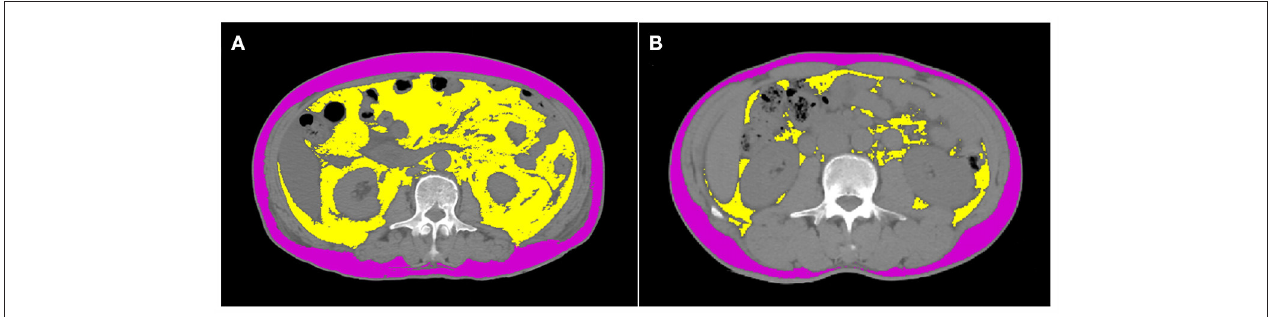
FIGURE 1 | Computed tomograph scan shows the body composition of normal BMI individuals with and without visceral obesity. (A) represents a normal BMI with visceral obesity, with a BMI of 23.2 kg/m 2 and visceral adipose tissue of 207 cm 2 . (B) represents a normal BMI without visceral obesity, with a BMI of 23.2 kg/m 2 and visceral adipose tissue of 23.9 cm 2 . Visceral adipose tissue area is highlighted in yellow and the subcutaneous adipose tissue area is purple.